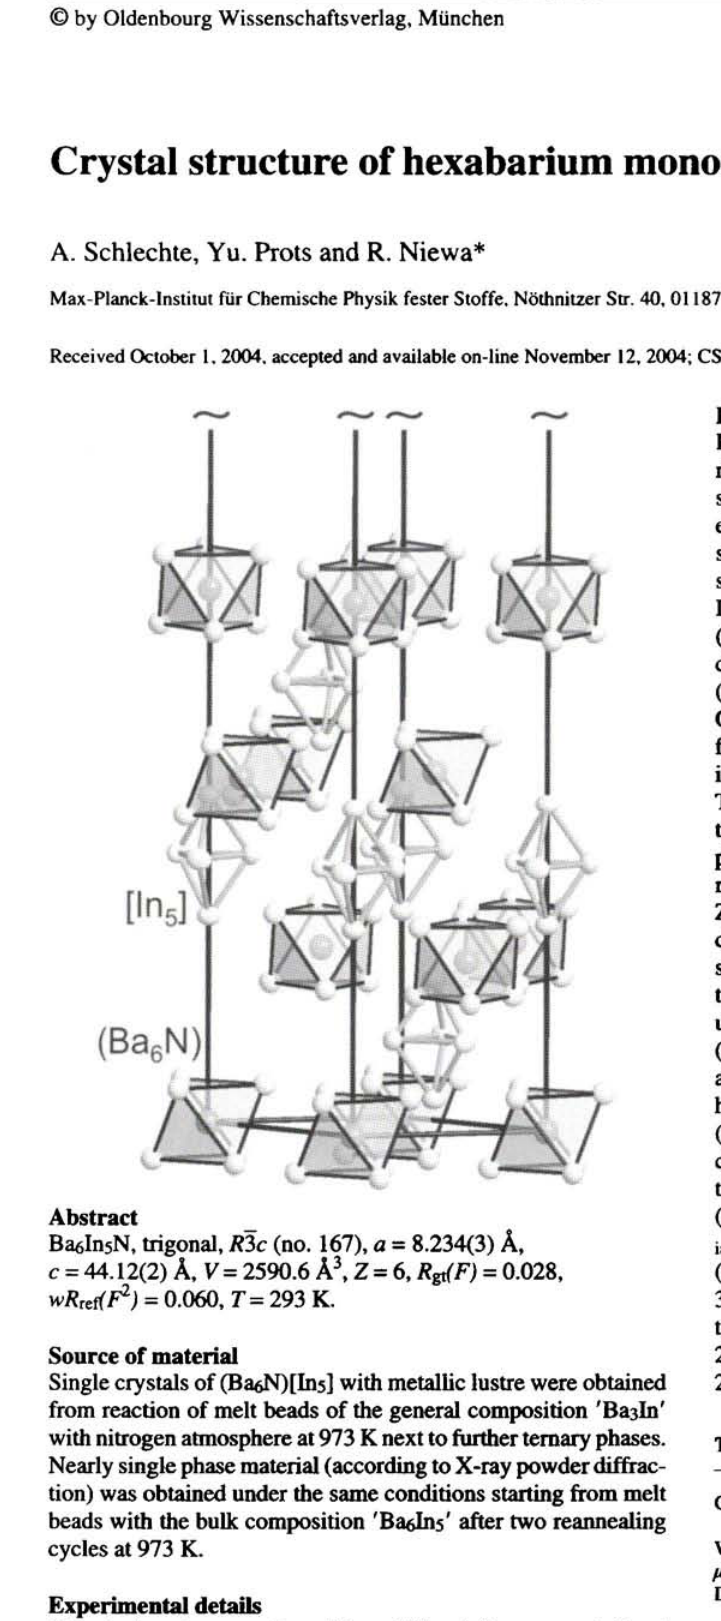
Table 1. Data collection and